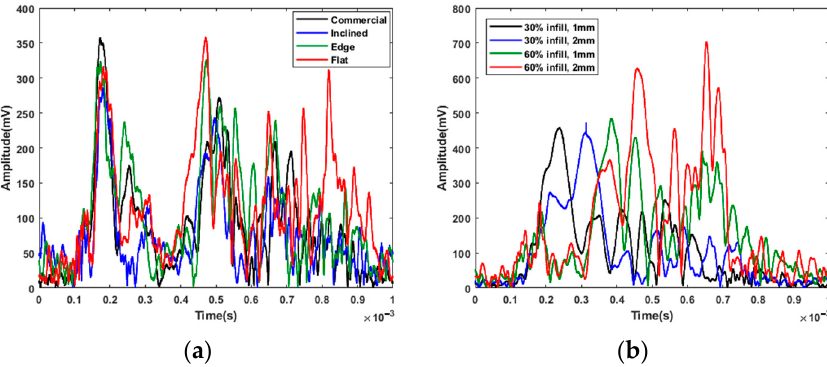
Figure 5. Envelope of the response for: ( a ) solid parts; ( b ) parts with infills.